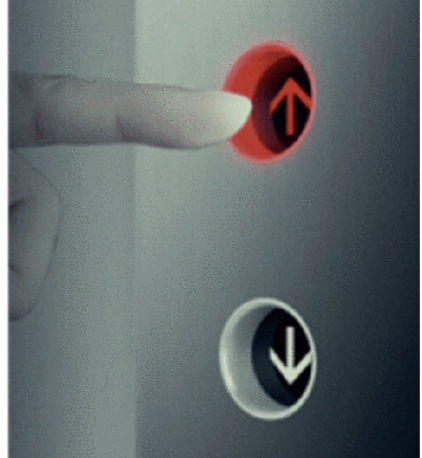
Figure 3. Infrared sensor button.